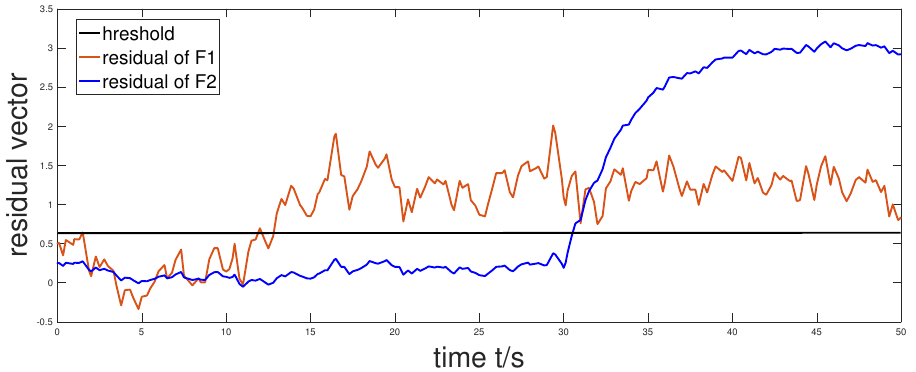
Figure 4. Response of residual vector ε ( t ) .